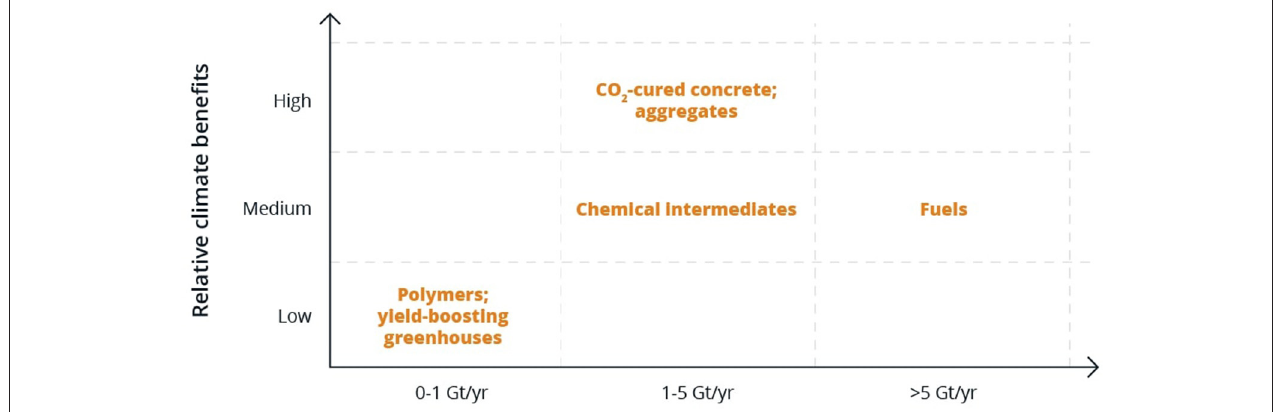
FIGURE 2 | Projected carbon removal potential and climate benefits of CO 2 -derived products and services adapted from International Energy Agency